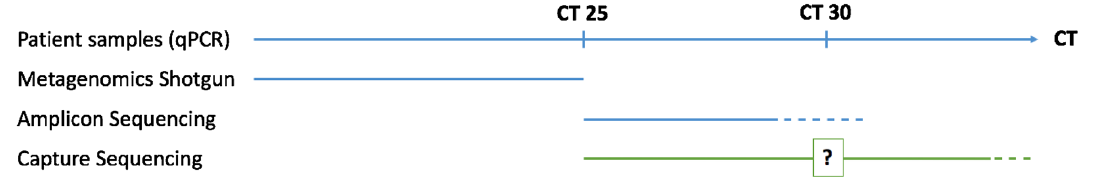
Figure 1. Molecular detection of SARS-CoV-2 by qRT-PCR and SARS-CoV-2 genome sequencing. Blue line: current strategy, green line: potential positioning of the capture